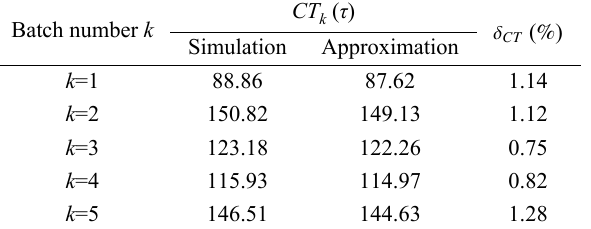
Table 4 Completion time and relative